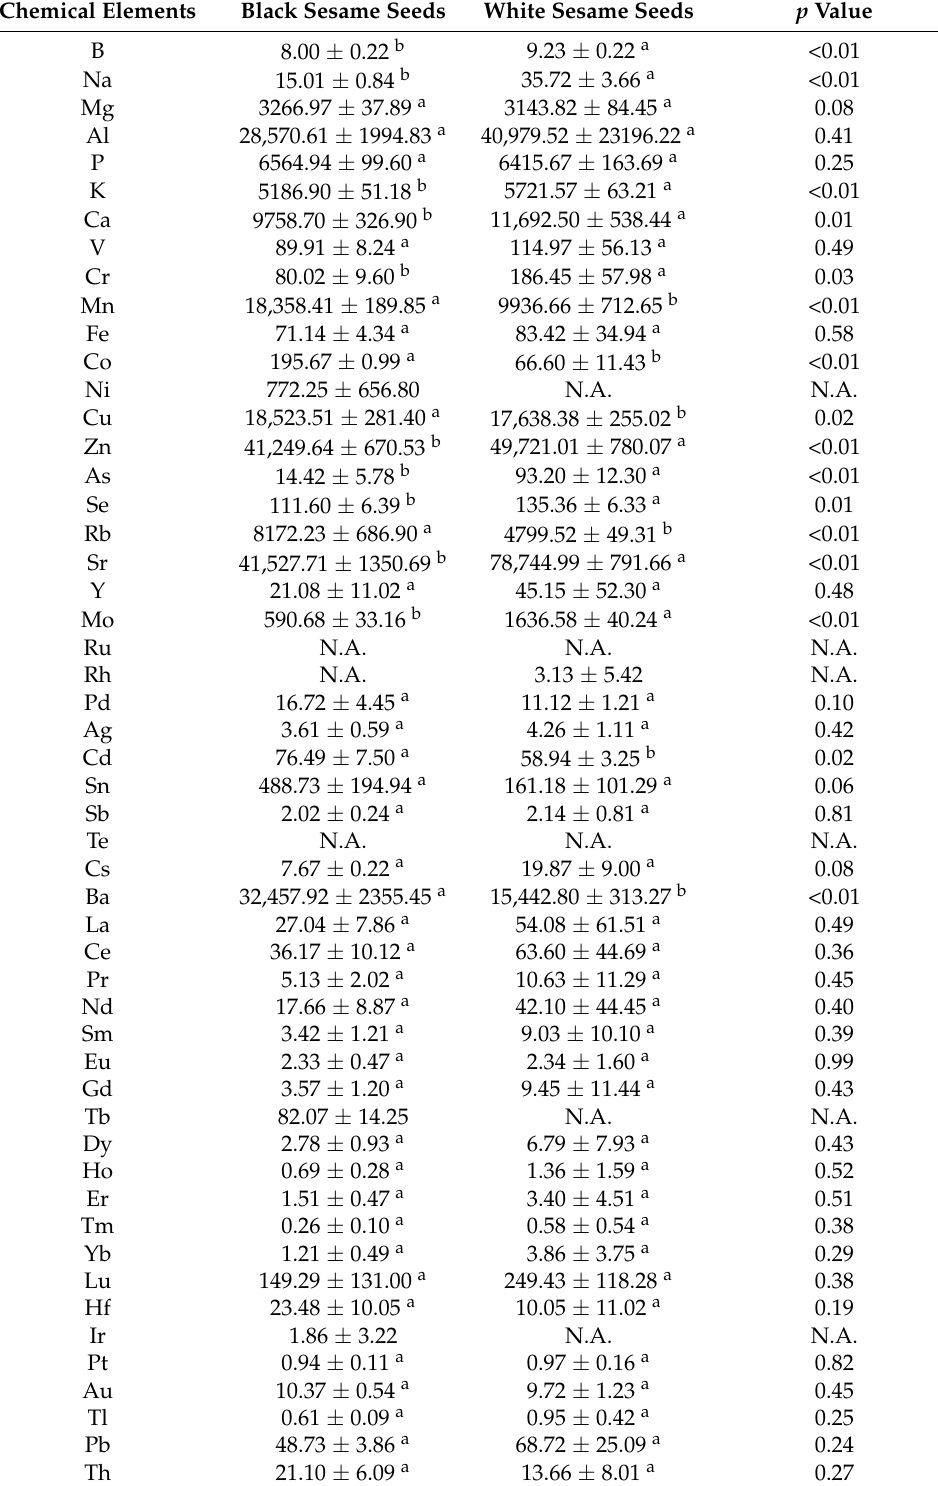
Table 1. Contents and statistical results of chemical elements determined in the sesame